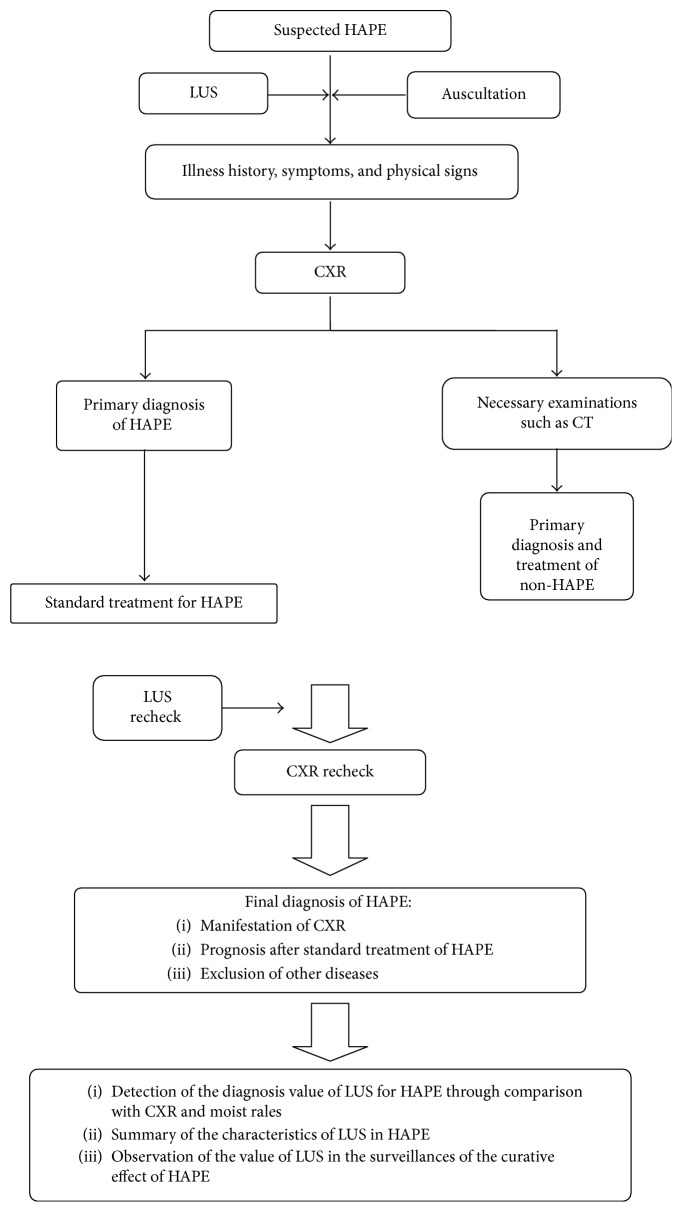
The study design.